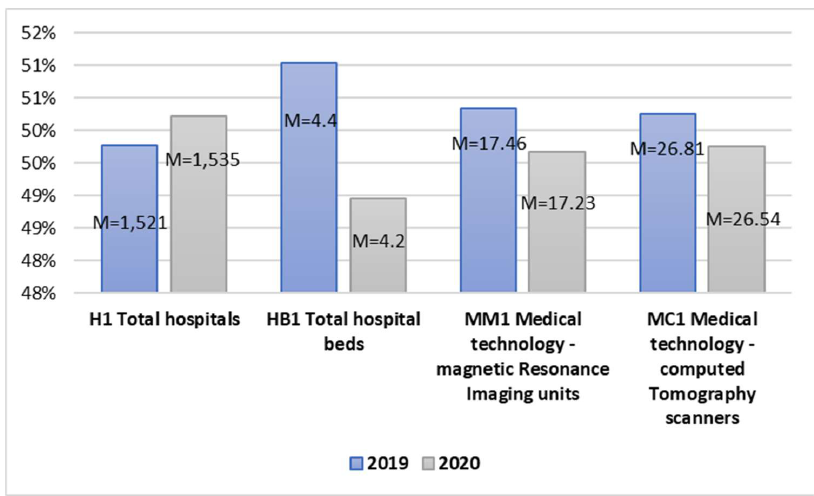
Figure 4. Independent sample mean values in the area of technical equipment in healthcare.